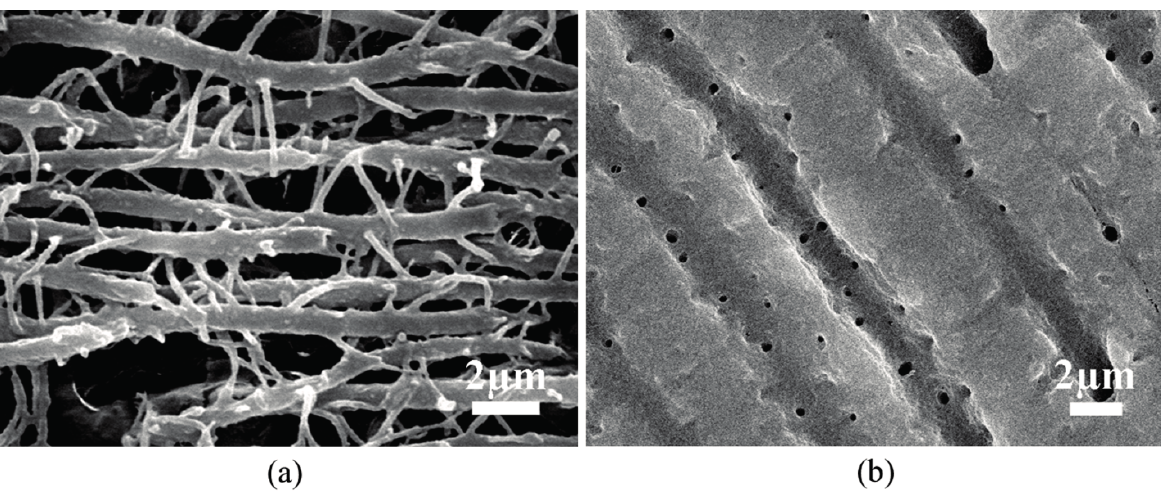
Figure 5. SEM images of the ( a ) fabricated hierarchical fibrillar structure and ( b ) hierarchical tubular structure in black carp dentine.